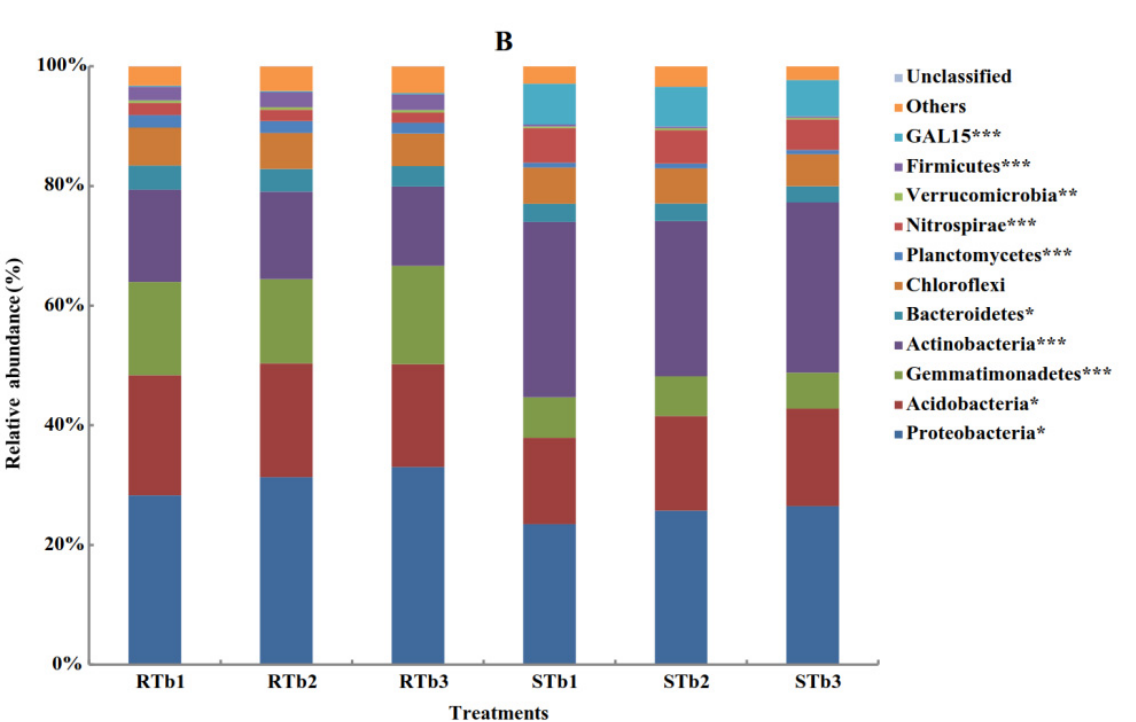
Figure 4. Comparison of the dominant bacterial communities at phylum level (%) in different samples. Number means three replications under the same treatment. ( A ) 0–10 cm; ( B ) 10–20 cm. Significant differences in relative abundance between different treatments are marked with a star: * p < 0.05, ** p < 0.01, *** p < 0.001, the same as below.